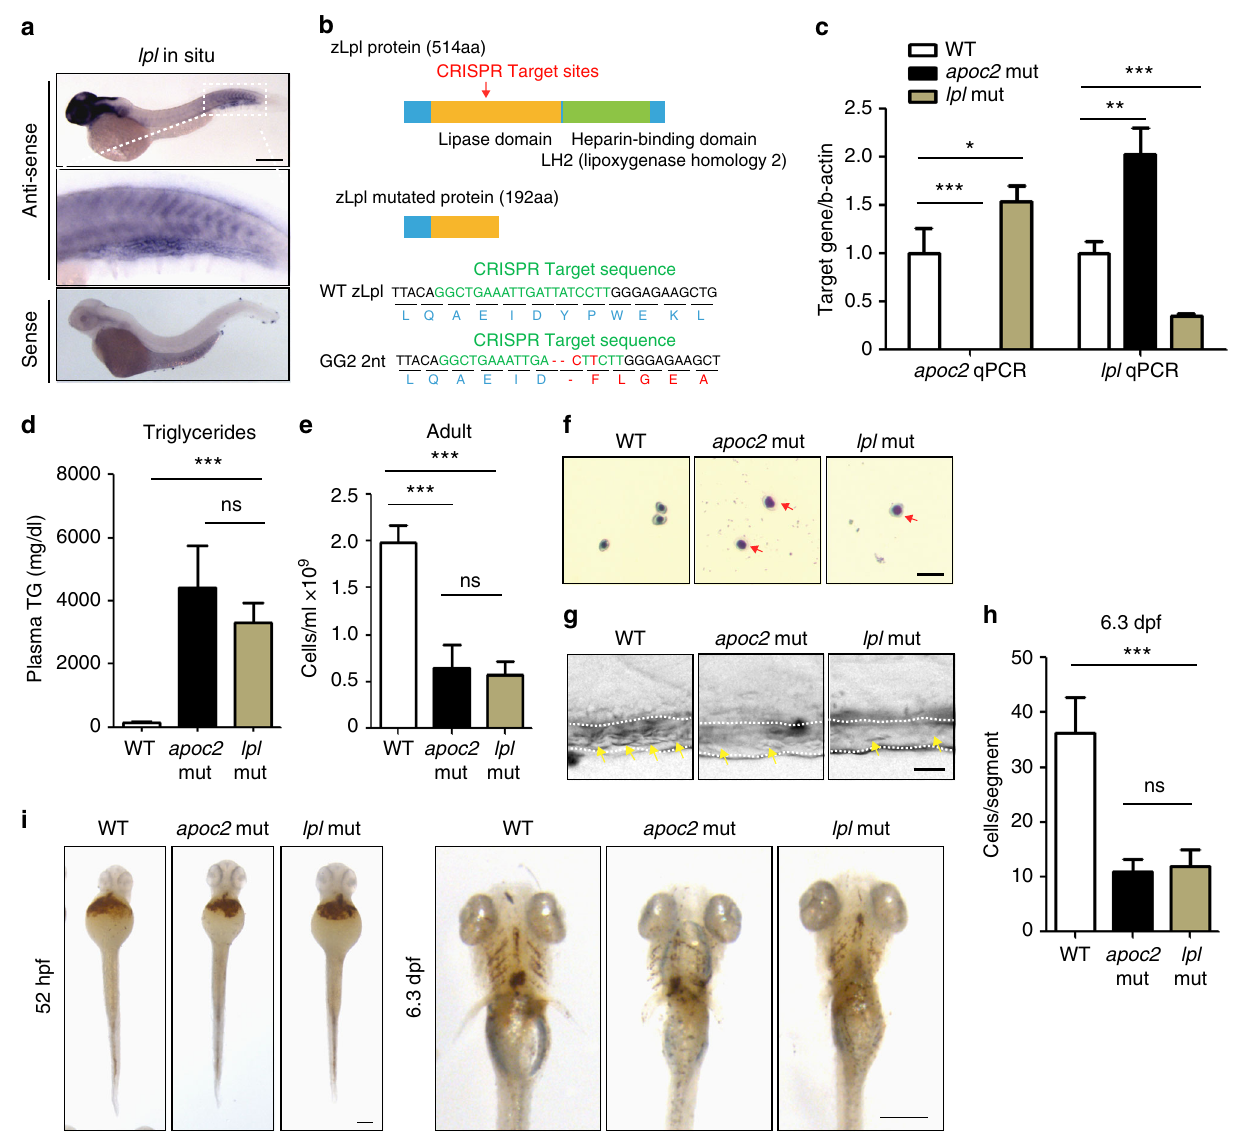
Fig. 2 Hematopoietic defects in lpl mutants. a In situ hybridization with lpl antisense and sence probes in WT embryos at 2 dpf. b Diagram of lpl CRISPR target sites and the predicted truncated protein caused by the 2 nt deletion, which results in a codon shift and premature translation termination. c qPCR results of lpl and apoc2 mRNA expression in WT, apoc2 and lpl mutants at 5 dpf ( n = 3 in each group). d Plasma TG levels in adult (9 – 15-month-old) male WT, apoc2 and lpl mutants ( n = 5 in each group). e Peripheral blood cell count in adult (15-month-old) male WT, apoc2 and lpl mutants ( n = 5 in each group). f Wright – Giemsa staining of blood smears from 6.3 dpf WT, apoc2 and lpl mutants. g , h Representative images and quantitative results of blood cell (yellow arrows) count in the caudal vein (outlined with white dashed lines) of WT, apoc2 and lpl mutants at 6.3 dpf ( n = 5 in WT and apoc2 mut groups each; n = 6 in lpl mut group). i o-Dianisine staining of 52 hpf and 6.3 dpf WT, apoc2 and lpl mutant embryos. Scale bars, 200 μ m in a ; 20 μ m in f , g , and 100 μ m in i . Quantitative results are mean ± SEM; * P < 0.05 and *** P < 0.001 (Student ’ s t Injection of human VLDL into WT embryos at 2 dpf enhanced expression of HSPC and erythrocyte markers at 80 hpf, suggesting that oversupply of the TG substrate for Lpl-mediated hydrolysis promotes, rather than inhibits, HSPC expansion and erythroid differentiation in the CHT region at this speci fi c stage (Fig. 4f). Importantly, VLDL (which carries APOC2), but not LDL (which does not contain APOC2), rescued the defective hematopoiesis in apoc2 mutants when injected at 2 dpf (Fig. 4f). However, VLDL injection did not rescue the hematopoiesis defects in lpl mutants (Fig. 4f) because these zebra fi sh did not have functional Lpl to be activated by VLDL-delivered APOC2.